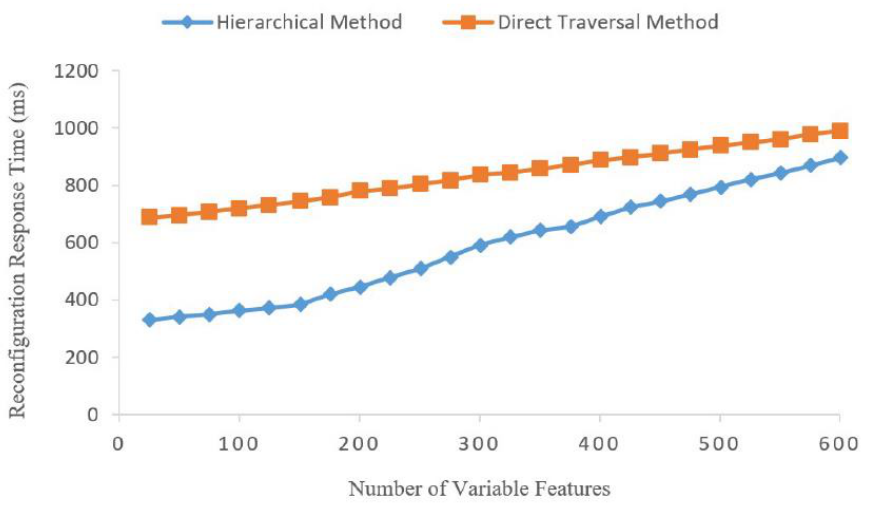
Figure 10. Response time for different methods.